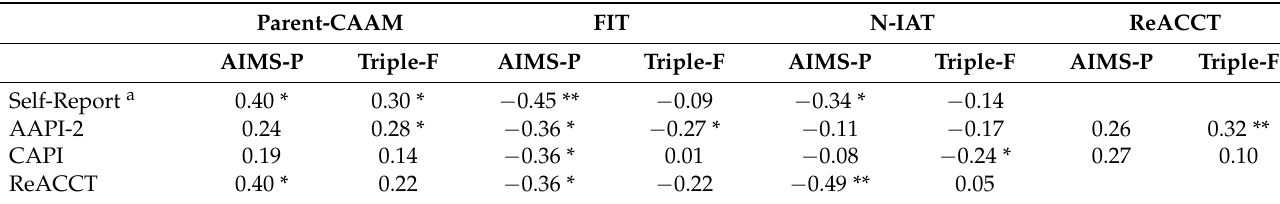
Table 3. Partial Correlations by Sample